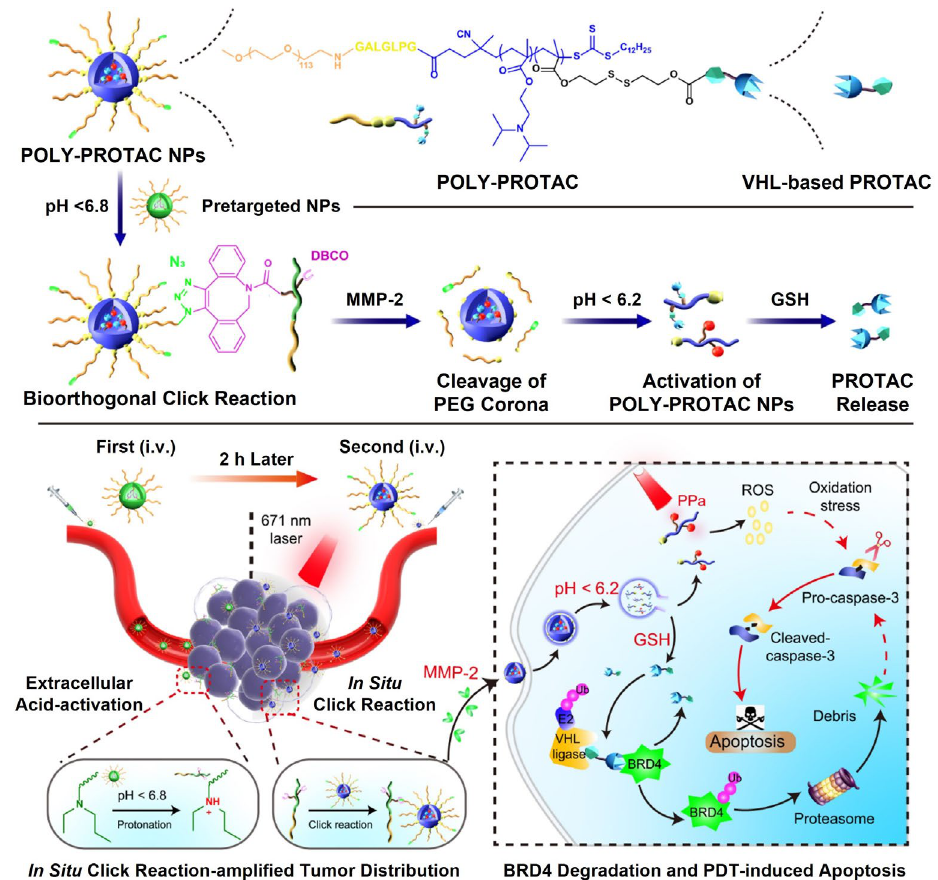
Figure 5. Active targeting nanoparticle-based PROTAC delivery. A multifunctional polymeric nanoparticle was proposed for combination cancer therapy through the co-delivery of PROTAC and photosensitizer. The polymeric nanoparticle was designed to be specifically delivered to tumors via bioorthogonal chemistry and to discharge free PROTACs in response to MMP-2, acidic pH, and GSH. The PROTAC and photosensitizer co -delivered to tumor tissues cooperatively acceler- ated the cancer apoptosis. Reproduced with permission from [119]. Copyright 202 2, Nature Pub- lishing Group.